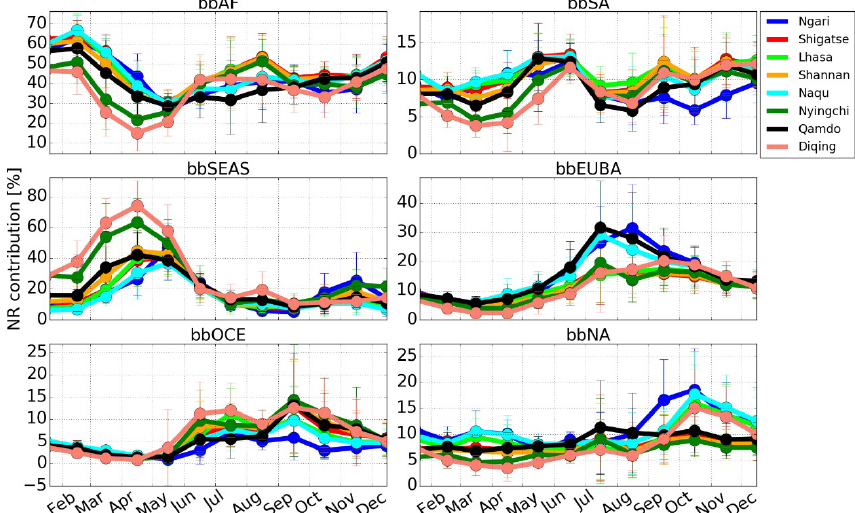
Figure 9. Monthly mean contributions of each geographical BB tracer to the total BB-associated CO transport to the HTP. The vertical error bar represents the 1 σ standard variation within that month. See Table 2 for a description of each